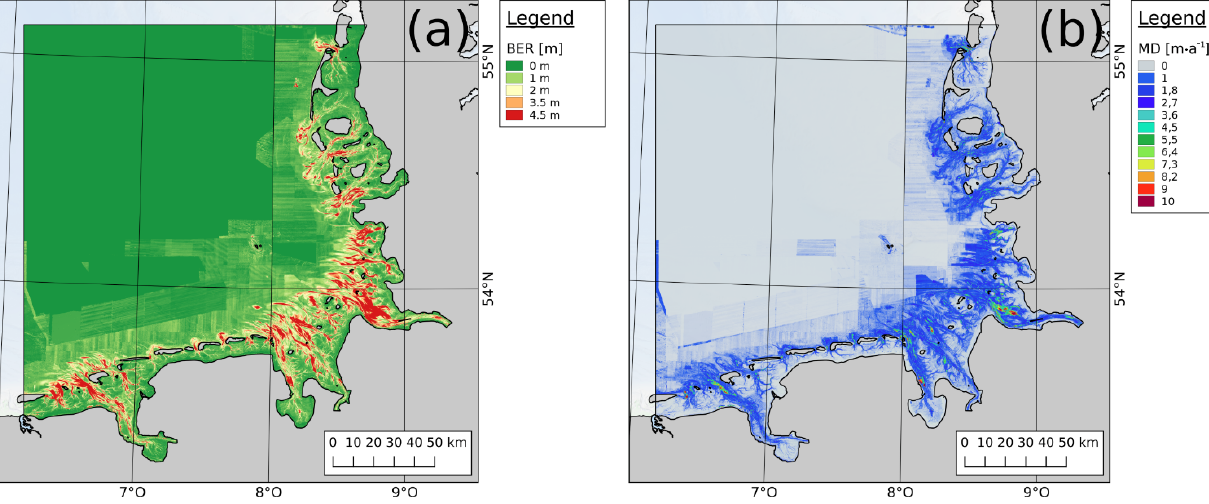
each median grain diameter ( d 50 ) gridded product is